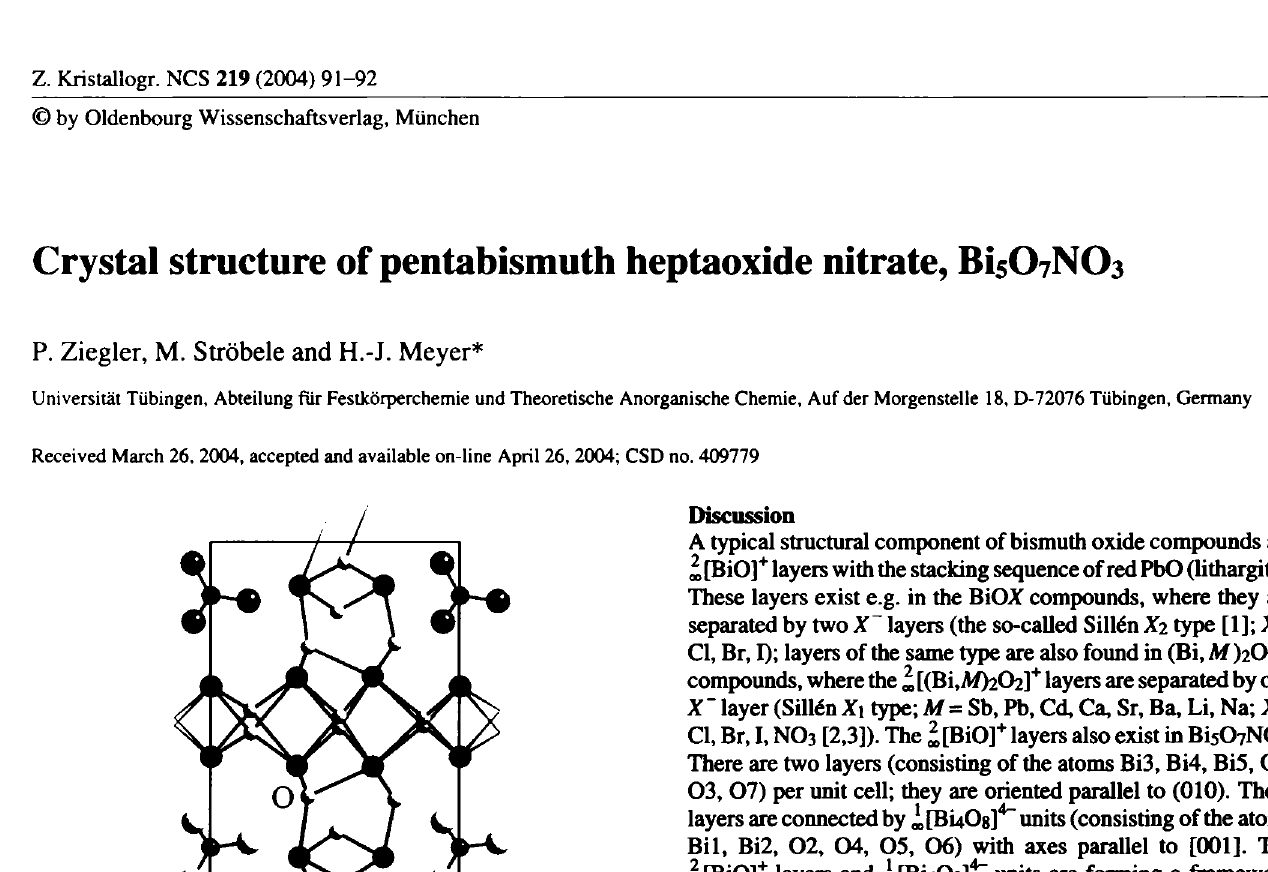
Table 1. Data collection and